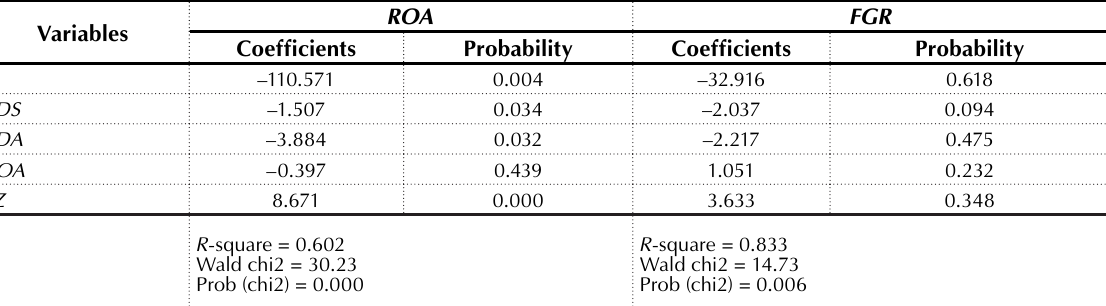
Table 5. Random effect